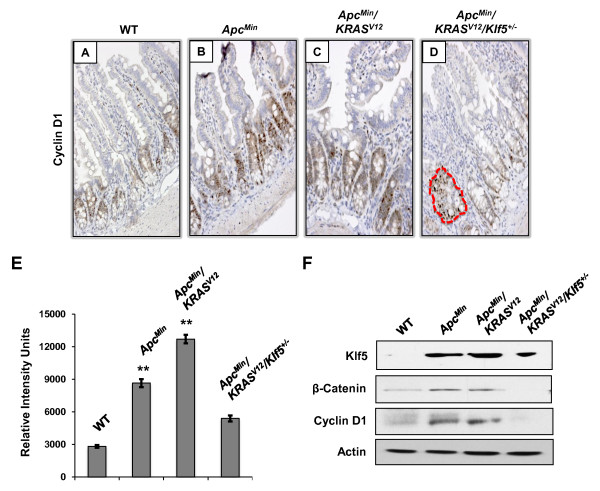
Immunohistochemical and Western blot analyses of cyclin D1 in the normal-appearing small intestinal tissues of wild type and mutant mice. (A-D) Immunohistochemical staining of cyclin D1 in the normal-appearing small intestines of wild type (WT) and mutant mice. A small focus of adenomatous tissue is demarcated by the red broken lines in panel D. (E) Quantification of cyclin D1 staining intensities in all fours sections using the Metamorph image analysis software. N = 10; **, P < 0.01. (F) Western blot analyses of Klf5, β-catenin, and cyclin D1 in the small intestines of wild type and mutant mice. Actin serves as a loading control.